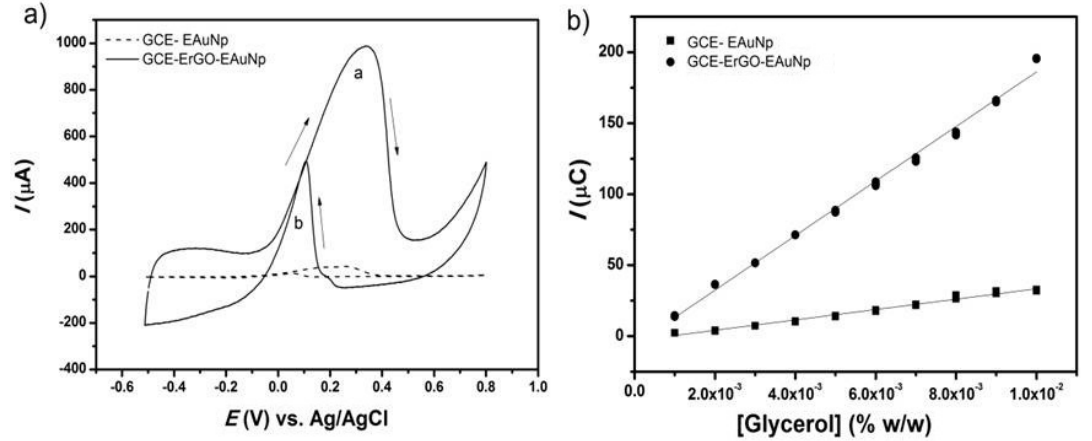
Figure 4. Cyclic voltammograms of GCE and EAuNp with (GCE-ErGO-EAuNp and without reduced graphene (GCE-EAuNp) modification in 0.2 mol L -1 KOH solution containing 3 mmol L -1 glycerol using 30 mV s -1 scan rate (a) and the respective analytical curves using GCE-EAuNp and GCE-ErGO-EAuNp